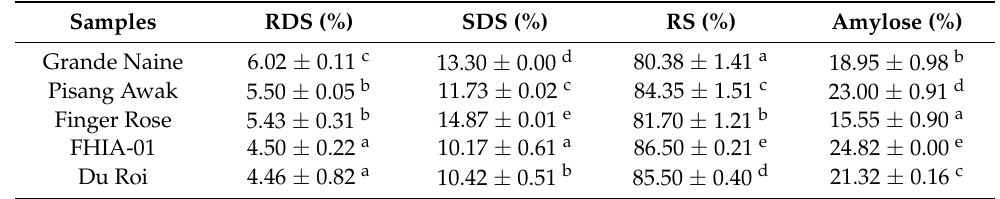
Table 5. Rapidly digestible starch (RDS), slowly digestible starch (SDS), resistant starch (RS) and amylose content green banana